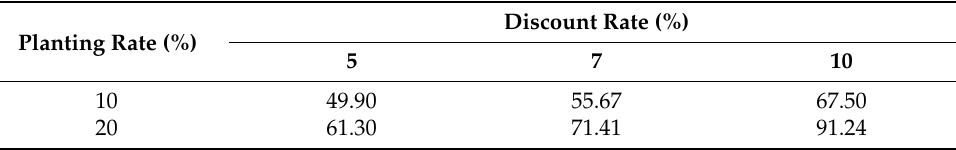
Table 6. Break-even carbon price in New Zealand dollars per New Zealand unit (NZD/NZU) of carbon at three discount rates (5%, 7%, and 10%) for planting native shrubs on 10% of the modelled farm at 10% and 20% planting rates per